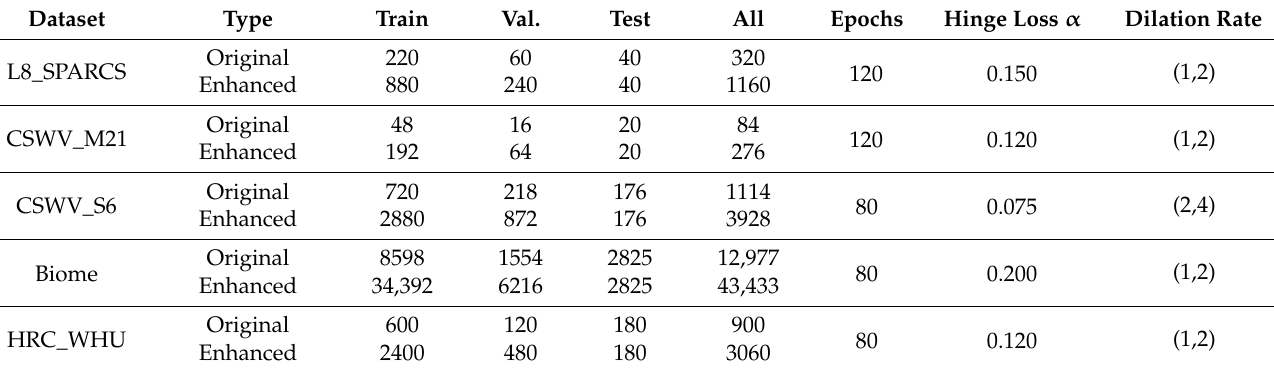
Table 2. The training details in different